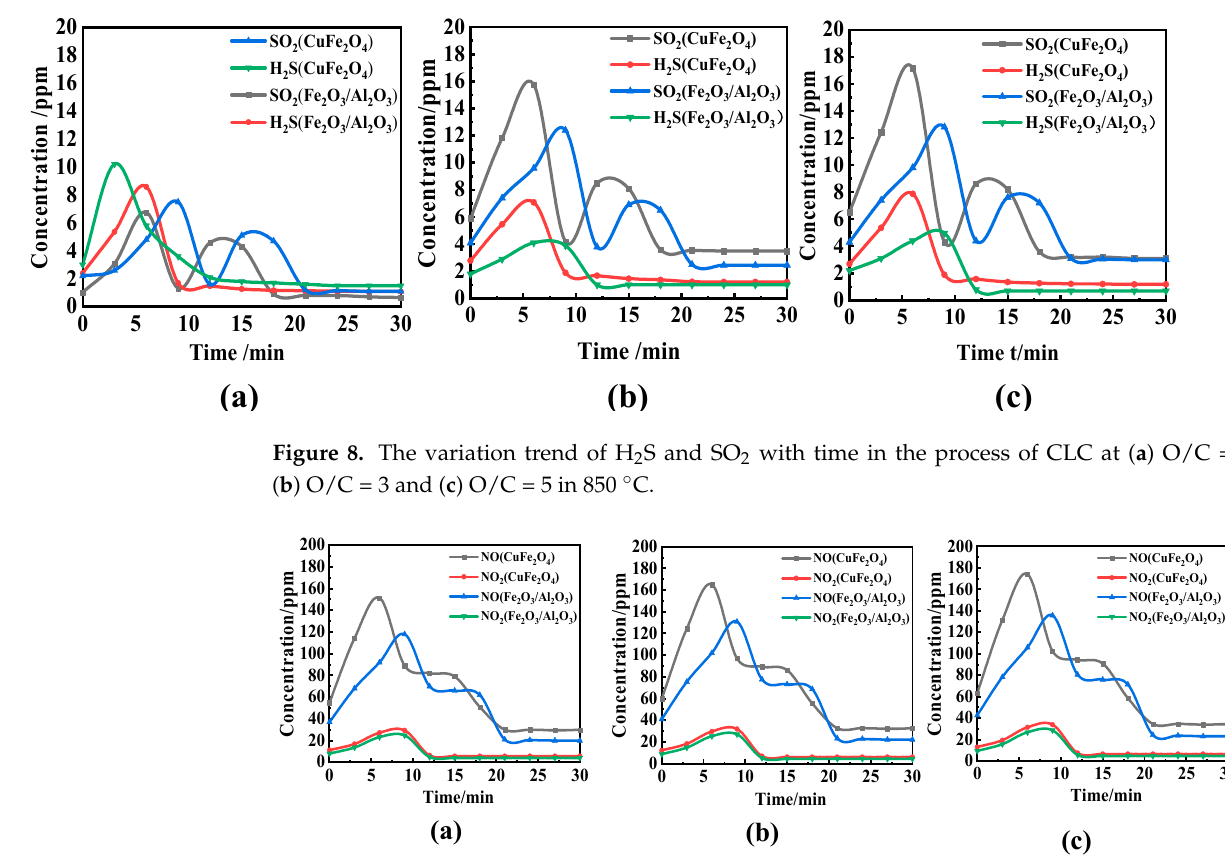
Figure 9. The variation trend of NO and NO 2 with time in the process of CLC at ( a ) O/C=1, ( b ) O/C=3 and ( c ) O/C=5 in 850 °C.